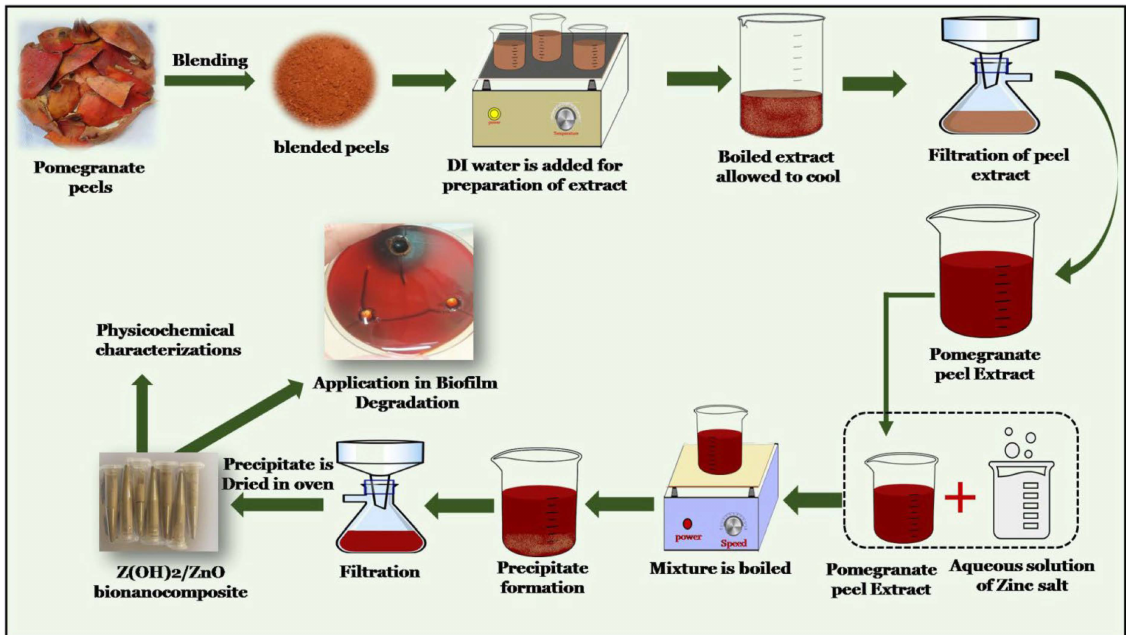
Figure 1. Schematic diagram for the preparation of the Zn(OH) 2 /ZnO